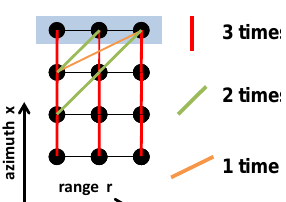
Figure 3: Schematic view of the counting algorithm to retrieve the lattice spanning vector corresponding to the horizontal alignment of PS in a regular alignment. The blue shaded row does belong to PS with the same planimetric position. Counting all directions of rows going through points belonging to this row, yields the numbers on the right hand side.